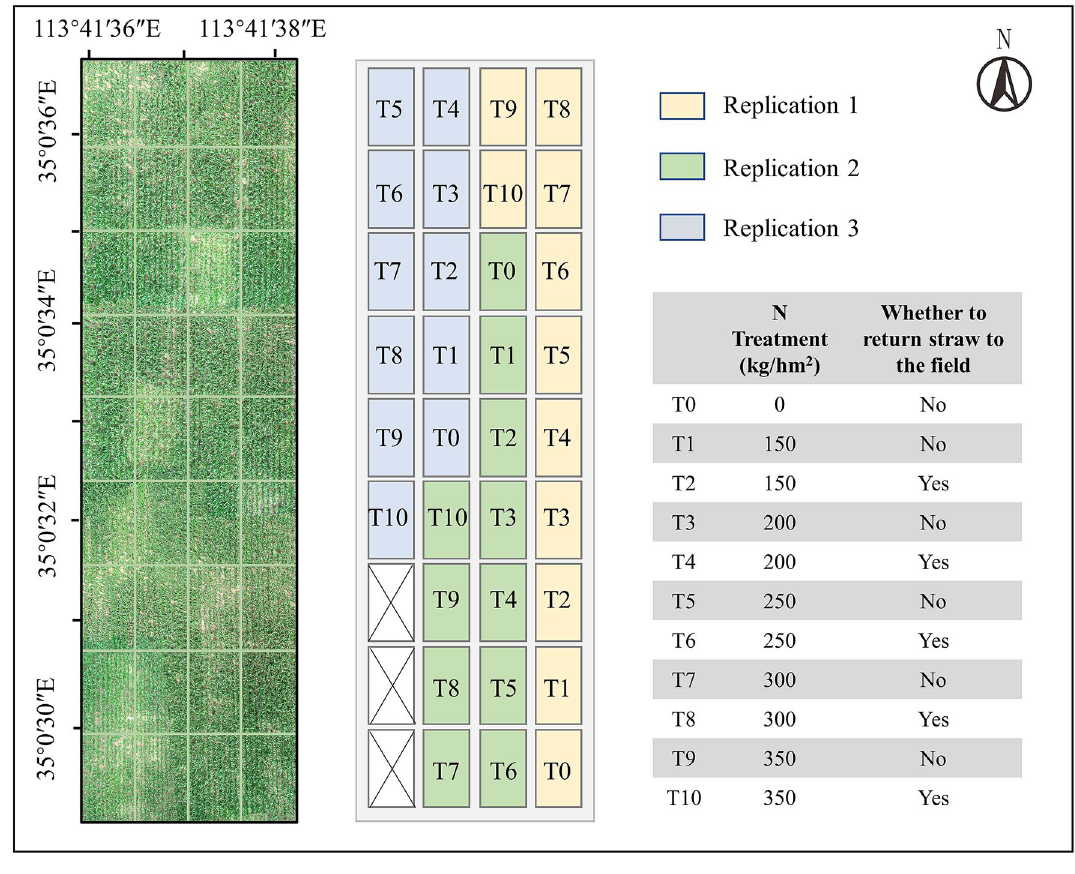
Figure 1. The experimental